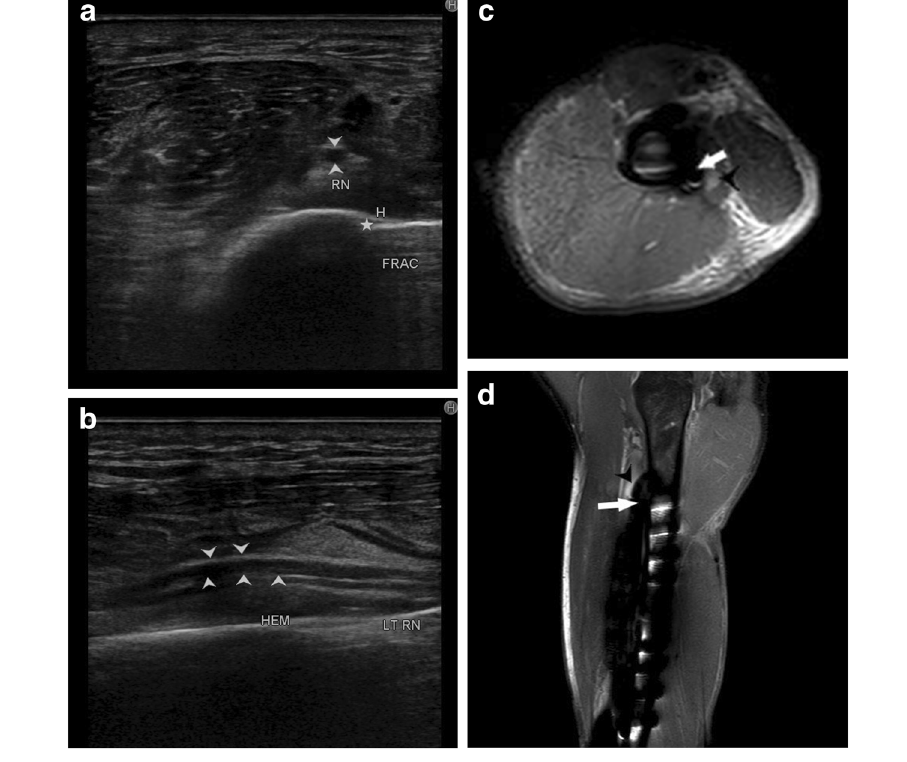
Fig. 8 a Displacement of radial nerve (arrowhead) is seen due to a local hematoma (H) formed following traumatic fracture (asterisk) of humerus shaft. b Long axis view of the left radial nerve (arrowhead) showing displacement by local hematoma (HEM). c : Axial PD sequence showing hyperintense radial nerve (black arrowhead) displaced by underlying acute hematoma (white arrow) in a post-operative case of fracture of the humerus shaft. d Coronal PD sequence showing hyperintense radial nerve (black arrowhead) with underlying hematoma in acute stage. Also noted are screws of the medullary nail implanted for fixation of the fracture of the humerus